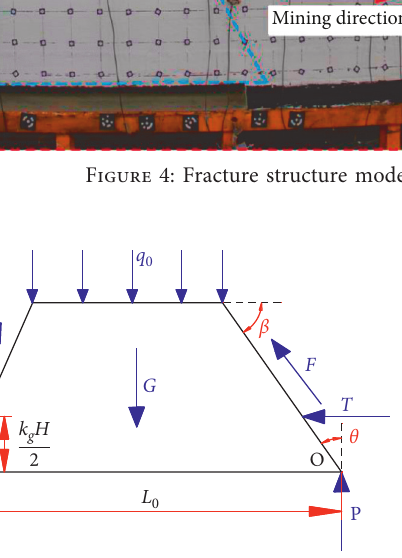
Figure 5: Fractured block force analysis of the THR first weighting at a close distance.